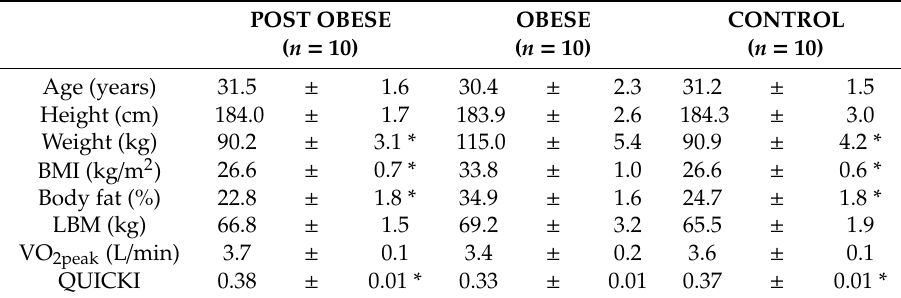
Table 1. Characteristics of Post obese, Obese, and Control male subjects. POST OBESE